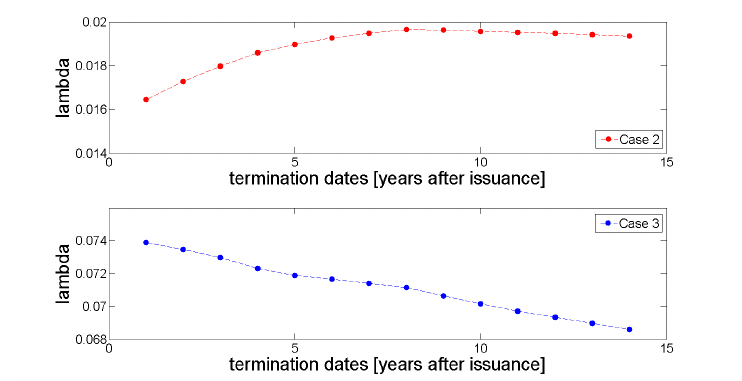
Figure 8. Means of Simulated Surrender